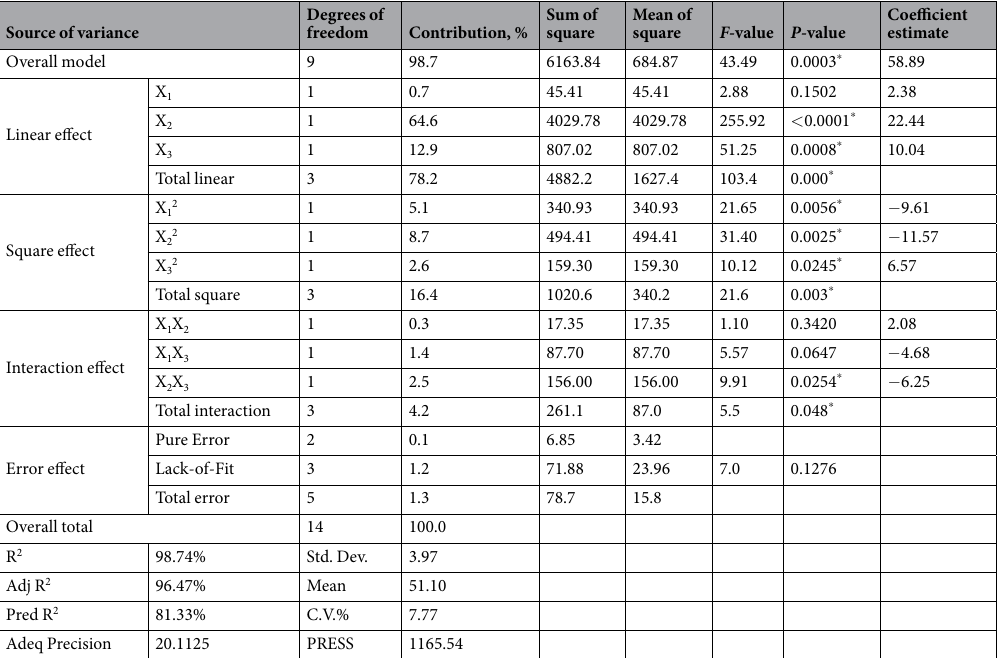
Table 2. Analysis of variance for the response surface of Cu 2 + removal % by Azotobacter nigricans NEWG-1 obtained by the Box-Behnken design. * Indicates significant effect. “Std. Dev. is the standard deviation, the coefficient of determination (R 2 ), Adj R 2 is the adjusted-R 2 , Pred R 2 is the predicted-R 2 and PRESS is the prediction error sum of squares, Adeq Precision is adequate precision, C.V is the Coefficient of